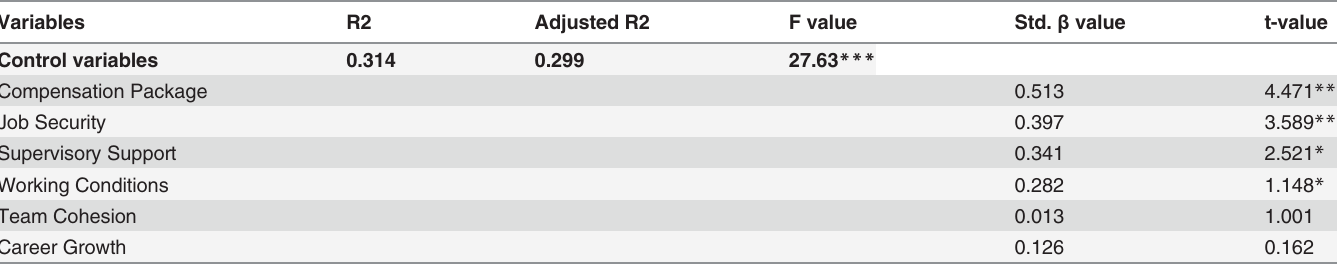
Table 3. Results of Multiple Regression